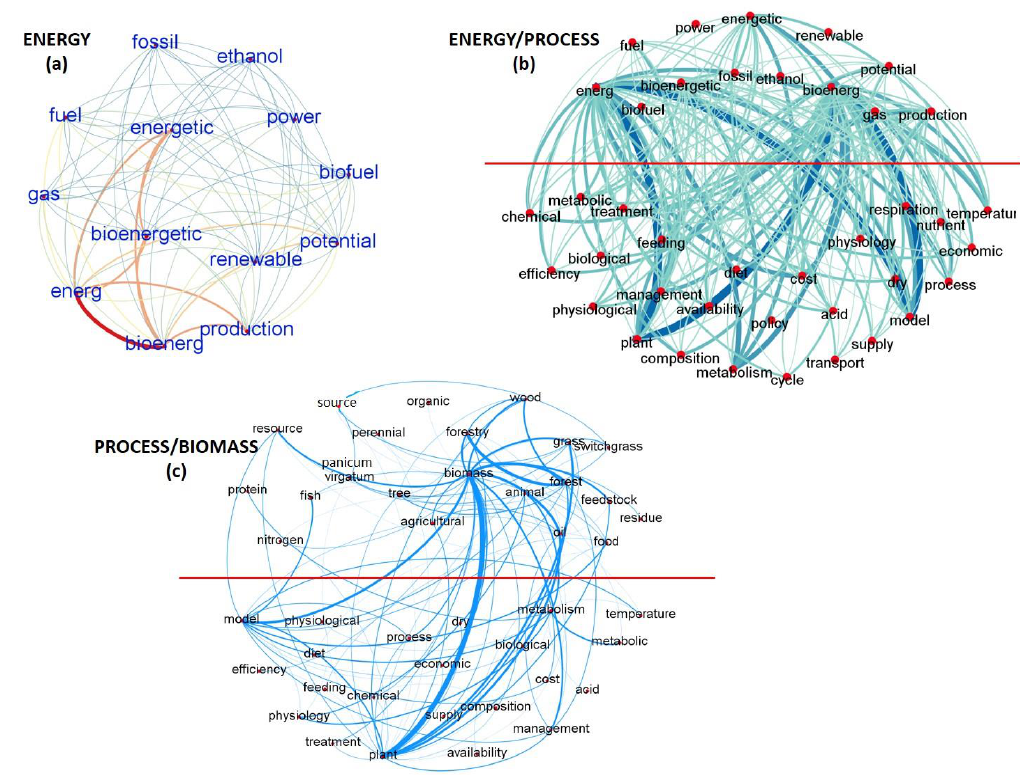
Figure 7. Co-occurrence of topics within the “Energy” cluster ( a ); between the “Energy” and the “Process” clusters ( b ); and between the “Process” and “Biomass” clusters ( c ). Table 8. Couples of terms with the highest number of relationships during the period 2000–2019, values of the